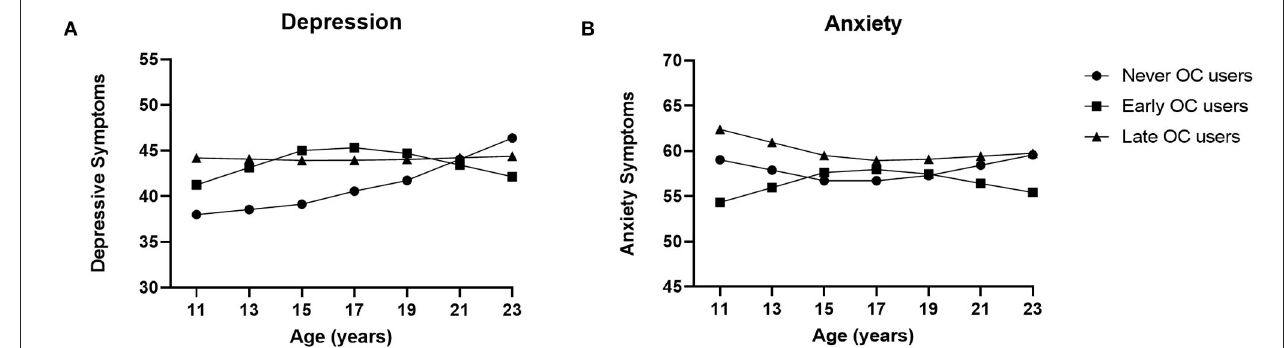
FIGURE 2 | Oral Contraceptive (OC) use, age of onset, and anxiety and depression modeled symptom trajectories. Growth curve models for the depressive and anxiety symptoms for never, early ( < 15 years), and late ( ≥ 15 years) users of oral contraceptives (OCs). (A) Never users increased significantly in depressive symptoms in late adolescence, whereas late pill users had a stable trajectory throughout adolescence and early pill users decreased in symptoms after age 16. (B) Never, early and late OC users did not show significantly different anxiety symptom trajectories in adolescence. Means are adjusted for sexual debut, romantic relationships, education level, religion, smoking history, alcohol use, and drug